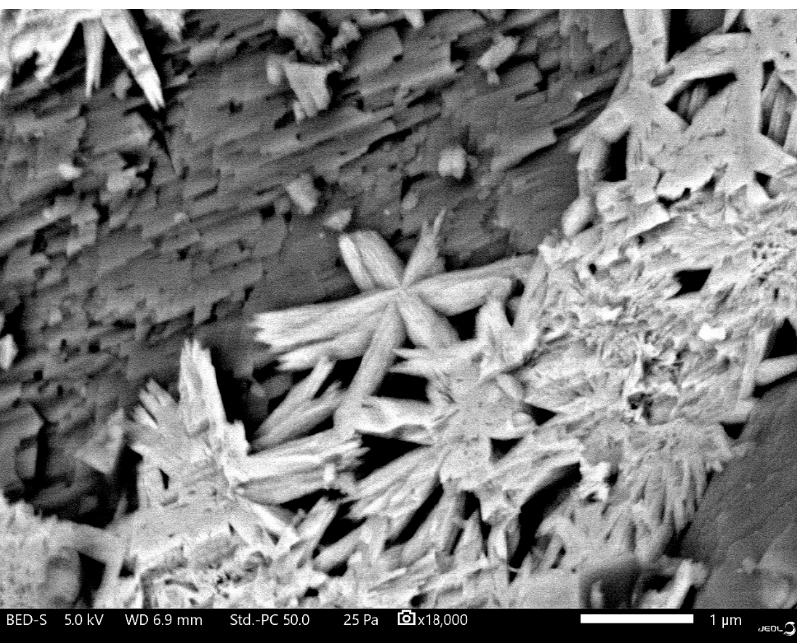
Figure 6. (A) Disk-shaped calcite crystals on the microcline surface, (B) Chemical composition of “A” surface area determined by EDS, (C) Element mapping of the “A” surface area. Source of the secondary CaCO 3 coating should be some non-pure microcline particle, caused by sampling error (see Figure 7).